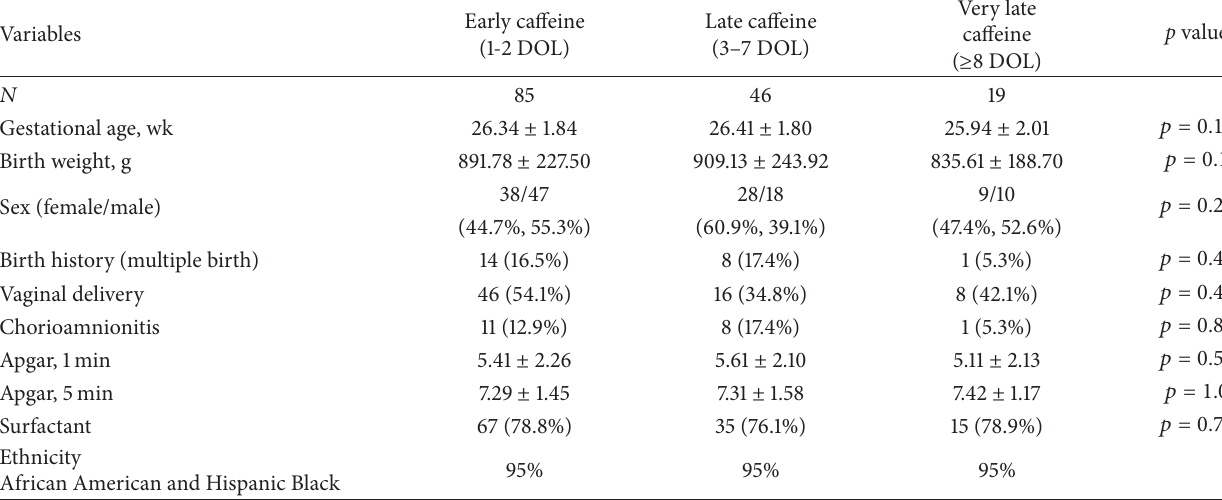
Table 1: Characteristics of preterm infants in this study 1